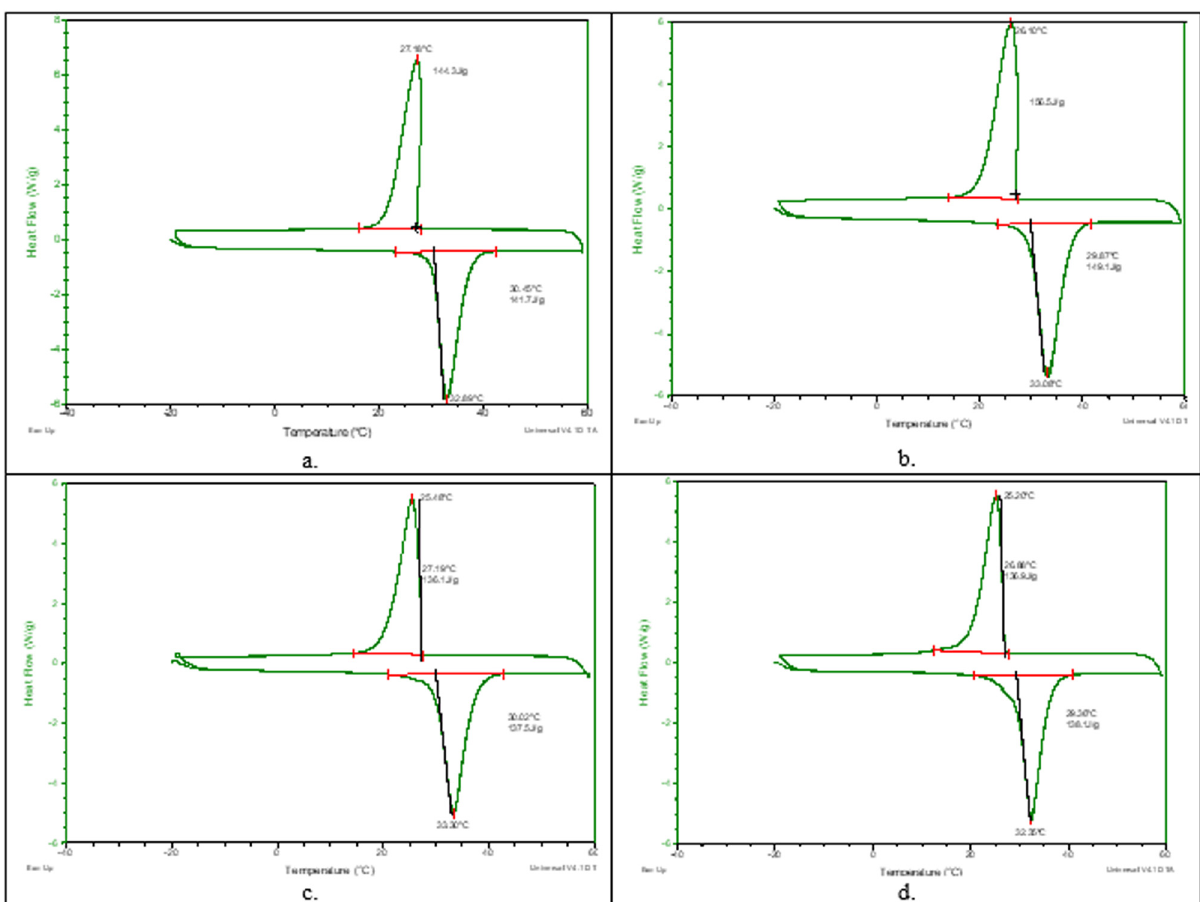
Figure 3: DSC thermal curves of tested PCM and prepared composites: CA ( a ) , CA/0.5% MWCNT ( b ) , CA/1% MWCNT ( c ) , and CA/3% MWCNT ( d ) .